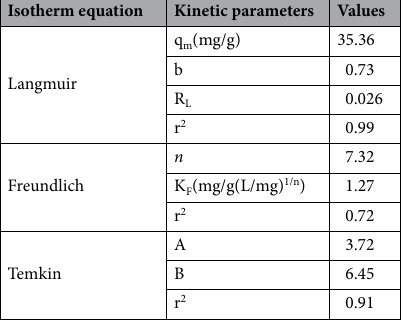
Isotherm equation Kinetic parameters